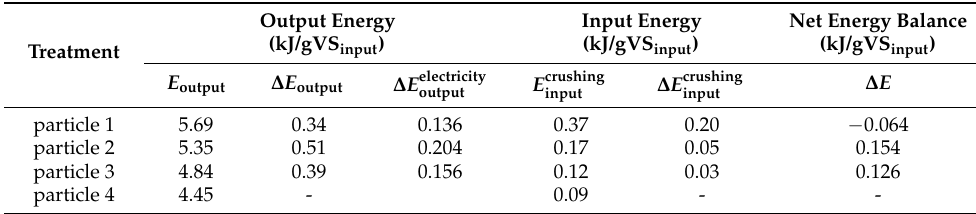
Table 5. Energy balance of different particle size